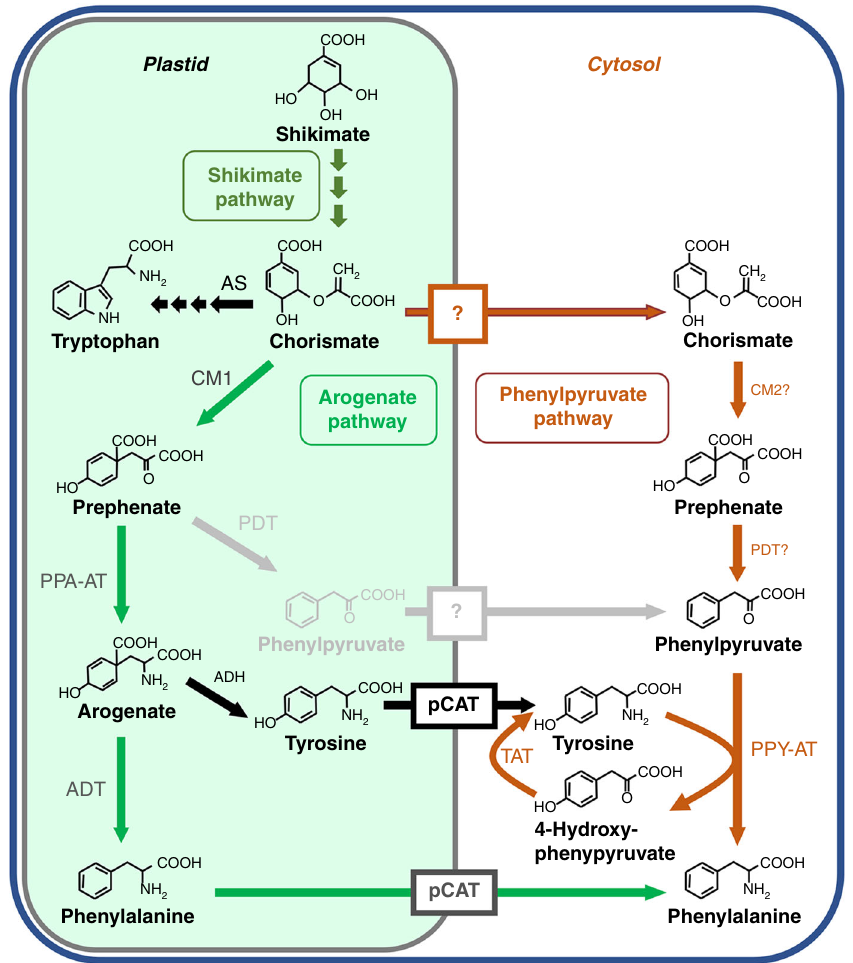
Fig. 1 Proposed plant phenylalanine biosynthetic pathways. Characterized enzymes and transporters are shown in solid colors. Uncharacterized enzymes and transporters (boxes) are shown in gray or with question marks. ADH arogenate dehydrogenase, ADT arogenate dehydratase, AS anthranilate synthase, pCAT plastidial cationic amino acid transporter, CM chorismate mutase, PDT prephenate dehydratase, PPA-AT prephenate aminotransferase, PPY-AT phenylpyruvate aminotransferase, TAT tyrosine